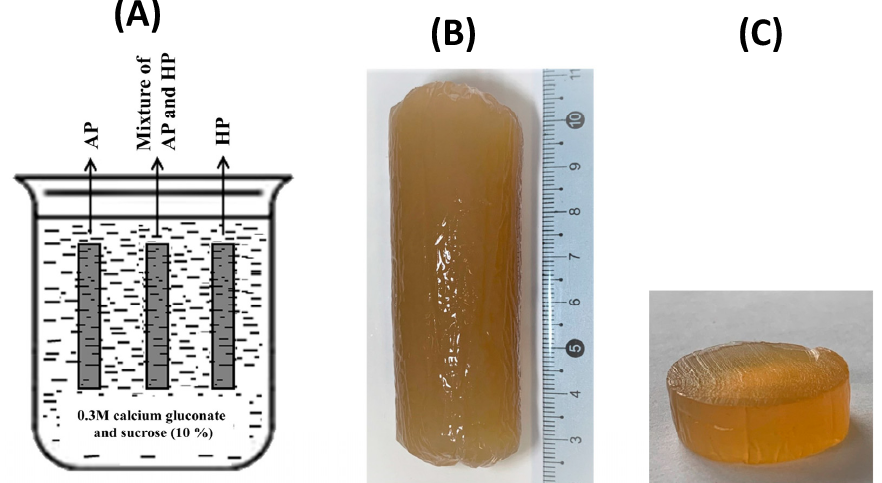
Figure 8. Preparation of hydrogels. General scheme ( A ), a representative image of PG3 hydrogel formed in a dialysis bag ( B ), and puck-shaped PG3 sample used for analyses ( C ). Cylinder-shaped (7–8 cm high) hydrogels were formed (Figure 8B). After being re-